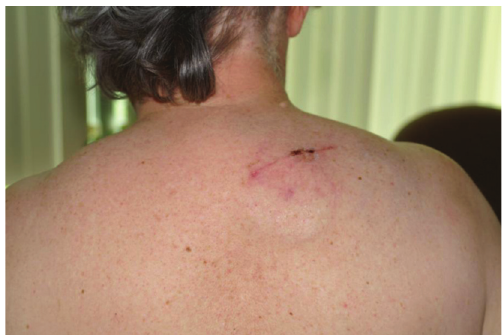
Figure 5: Postoperative appearance of the IPG implanted in the suprascapular region after the last surgery.